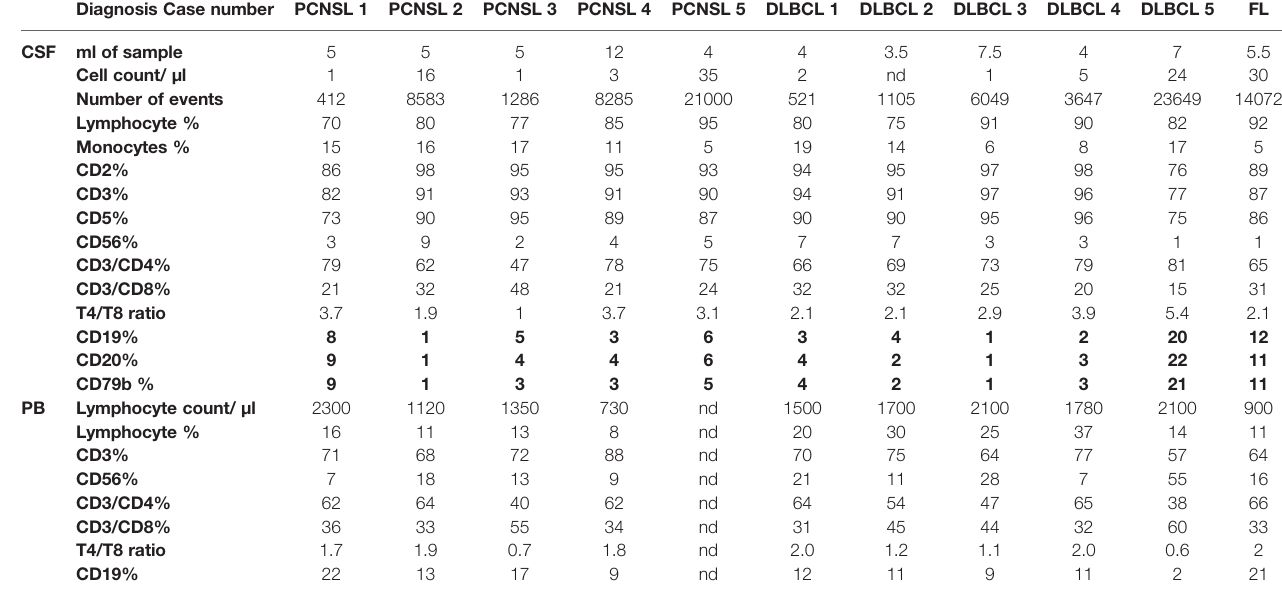
TABLE 3 | Analysis of the cerebrospinal fl uid (CSF) and corresponding peripheral blood (PB) lymphocytes of 11/107 non-Hodgkin lymphoma patients, negative for leptomeningeal involvement, where a subpopulation of B cells has been identi fi ed at diagnosis by fl ow cytometry of the CSF